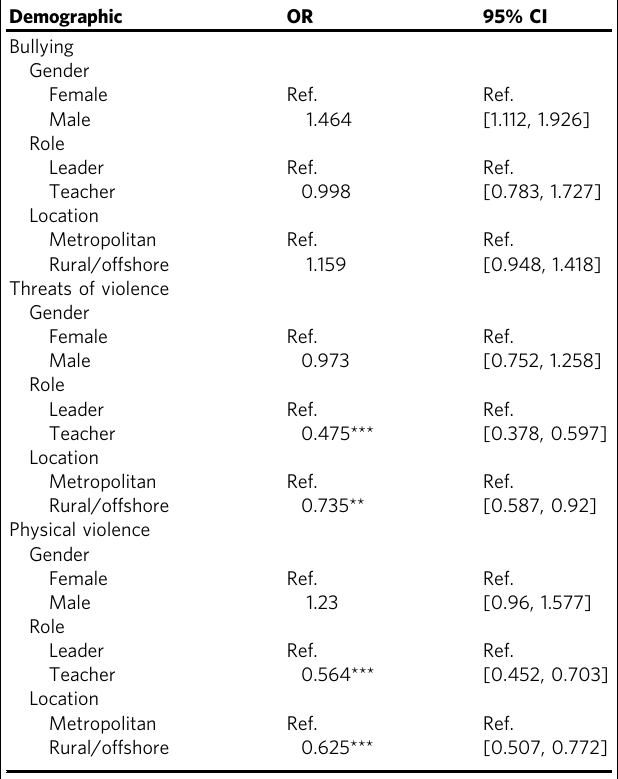
Table 4 Logistic regression results of government school leaders ’ and teachers ’ demographics predicting exposure to bullying, threats of violence and physical